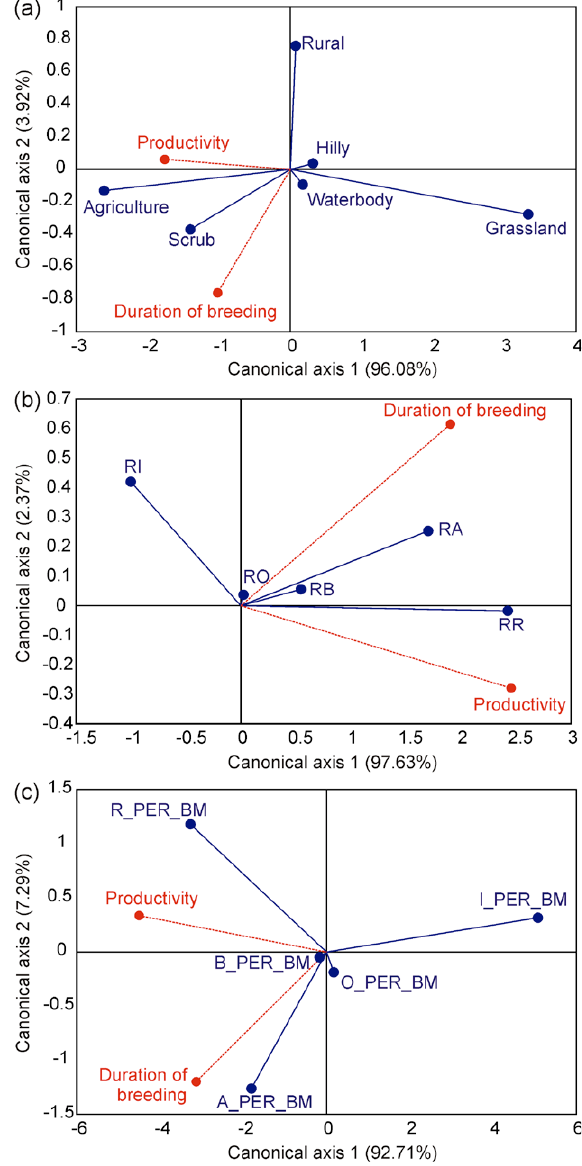
Figure 3. Redundancy analysis (RDA) depicting the canonical correlations between productivity and duration of breeding of the owls and (a) habitat, (b) relative abundance of prey and (c) percent biomass of different prey items. Percentage in parenthesis is the percentage variation explained by each canonical axis. Key: R_PER_ BM, percentage biomass of rodents; A_PER_BM, birds; B_PER_BM, bats; I_PER_BM, insects; O_PER_BM, other prey items. Other abbreviations are as per Figure